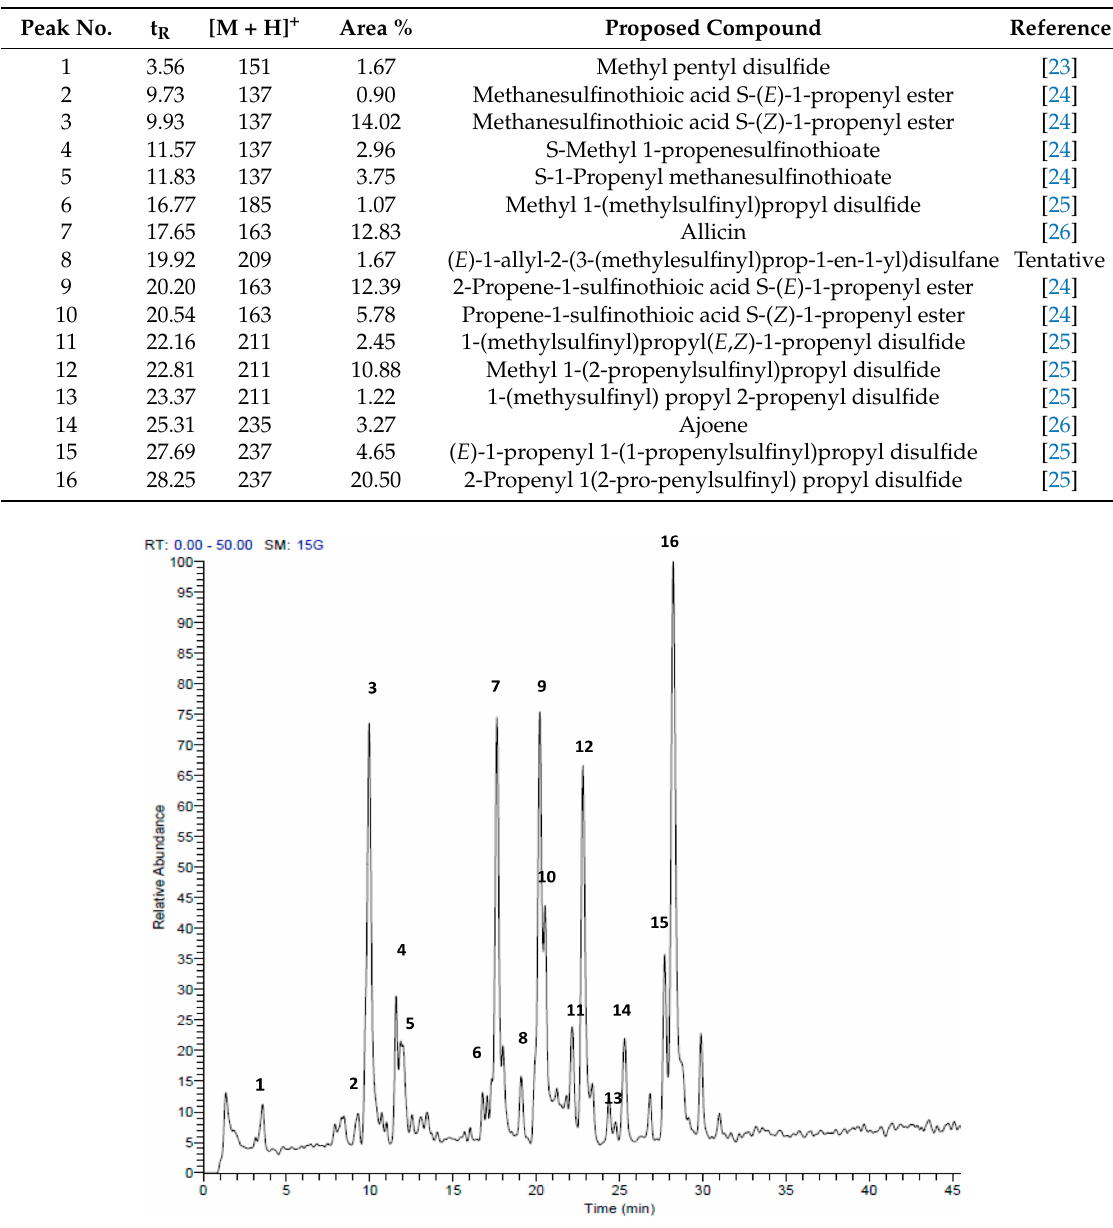
Figure 2. HPLC-MS/MS profile of Allium ursinum extract in the positive mode (+). Peak retention times correspond to compounds listed in Table 1.